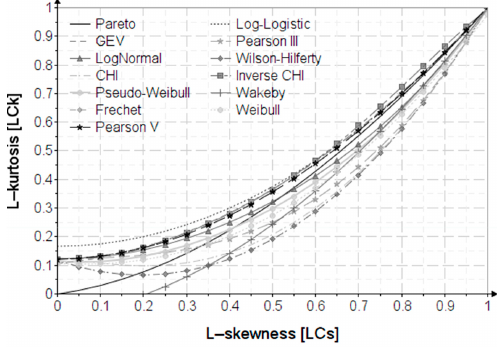
Figure A1. The variation diagram of LC s − LC k